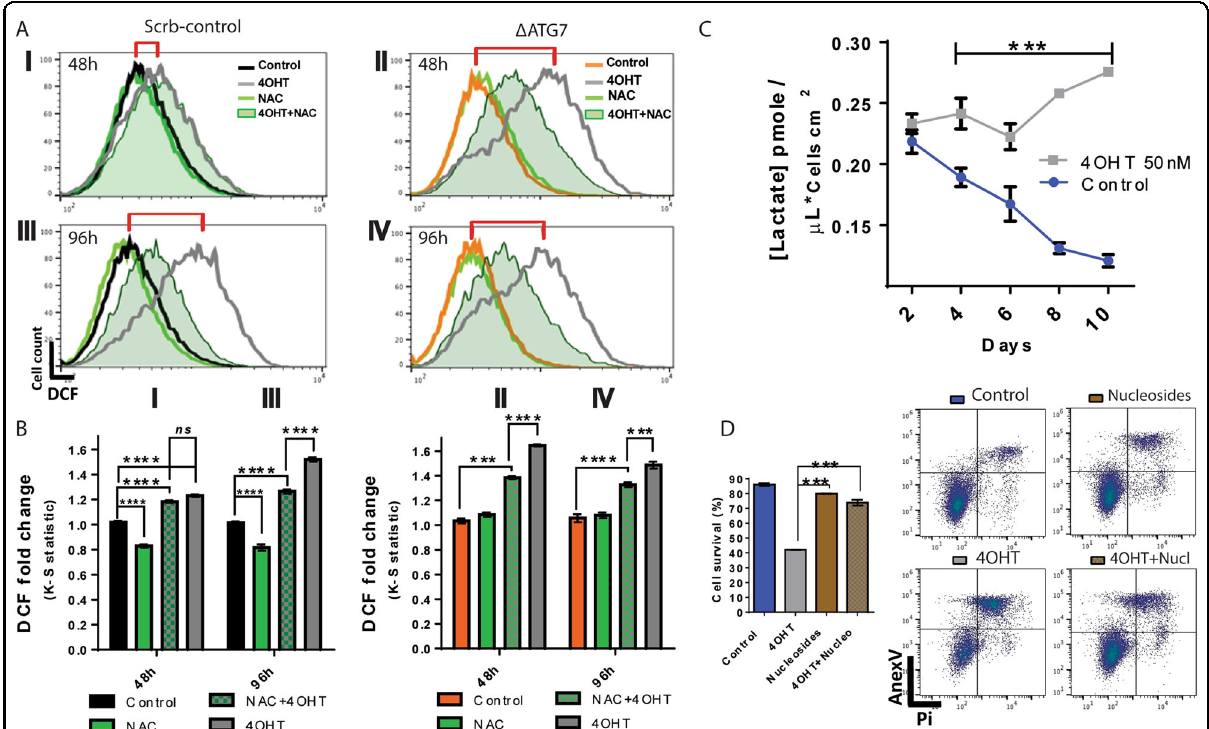
Fig. 7 Autophagy buffers the levels of ROS, reducing the DNA damage caused by oxidative species, hence increasing the survival of keratinocytes transitioning to a malignant transformed phenotype. A Flow cytometry measurements of reactive oxygen species (ROS) through DCF fl uorescence. Autophagy-competent (Scrb keratinocytes I – III) and autophagy-de fi cient keratinocytes ( Δ ATG7 keratinocytes II – IV) were induced with 50 nM 4OHT and treated with 5 mM NAC for 48 h (I, II) or 96 h (III, IV). The red brackets show the gradual increase in ROS levels in autophagy- competent cells and the fast increase of ROS levels in keratinocytes lacking autophagy. B Δ ATG7 keratinocytes increase in 70% of their ROS levels after 48 h of HRas G12V induction. The levels in autophagy-competent keratinocytes were much lower (20%). In addition, NAC treatment reduced steady-state levels of ROS in noninduced keratinocytes. The dislocation of the fl uorescent population was quanti fi ed by the Kolmogorov – Smirnov test (K – S). The graphs are representative of three independent experiments. C The conditioned culture media of ER:HRas G12V keratinocytes, 4OHT- induced and noninduced (control), were harvested for 10 days and had their lactate concentration measured. The graph is representative of two independent experiments carried out in triplicate. D The fl ow cytometry of cell viability assay stained with annexin-V/PI showed that deoxynucleoside treatment improved keratinocytes ’ survival under oncogenic stress promoted by HRas G12V activity. The ER:HRas G12V keratinocytes were plated in lower density to extend as much as possible the experiment. After 6 days, the cells were induced with 50 nM 4OHT, treated with 2 mM deoxynucleosides (deoxyadenine, -guanosine, -cytidine, and thymidine) and their respective controls had their viability measured. The graph is representative of two independent experiments. The different font sizes represent the intensity of the effect. For fl ow cytometry, 30 × 10 3 cells were considered per condition and time point. Data presented as a mean (SD). Two-way ANOVA, * P ≤ 0.05, ** P ≤ 0.01, and *** P ≤ 0.001, Bonferroni post